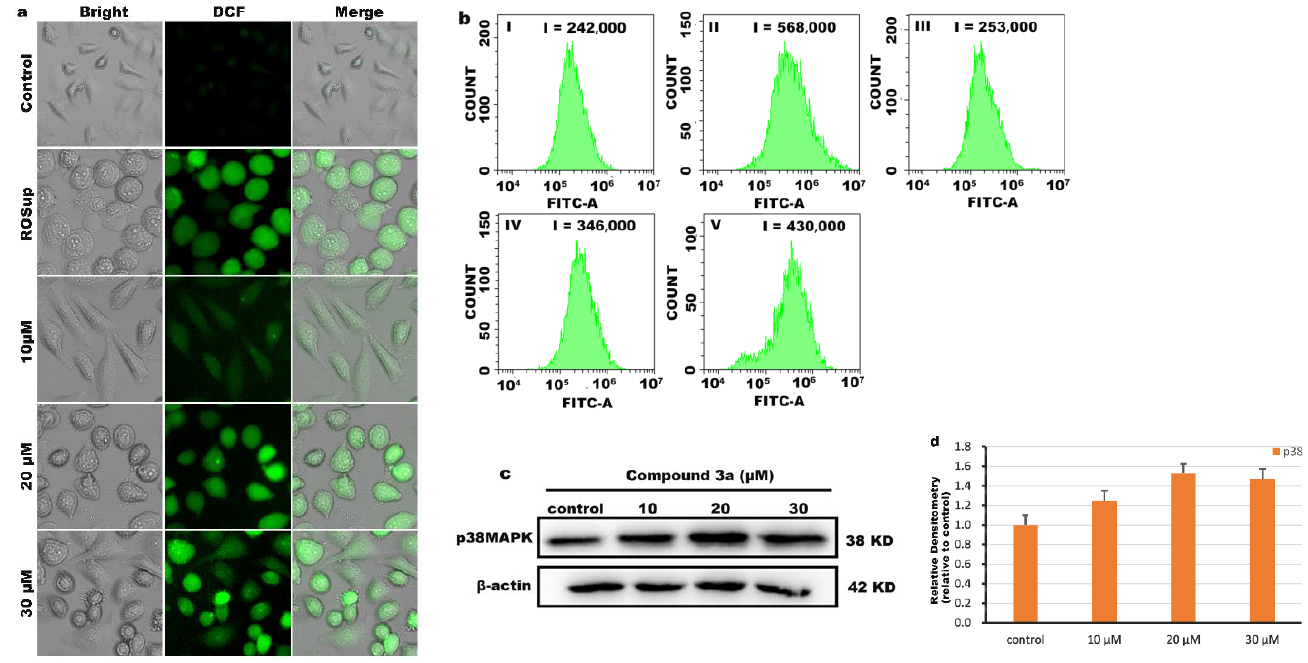
Figure 5. ( a ) Production of ROS in HeLa cells treated with different concentrations of compound 3a for 24 h was assayed. ( b ) Quantitative determination of DCF fluorescence intensity using flow cytometry ( I ) control group; ( II ) Rosup (a positive control); ( III ) 10 μM; ( IV ) 20 μM; ( V ) 30 μM of 3a . ( c ) The expression of p38MAPK after HeLa cells were exposed to 3a for 24 h. ( d ) Quantitative analysis of p38MAPK protein expression.